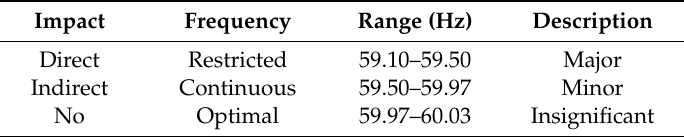
Table 3. Qualitative values of consequences.